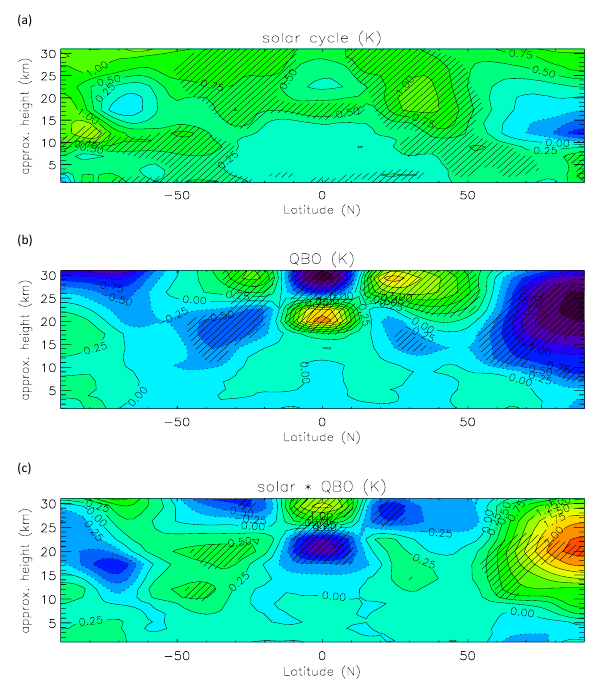
Figure 6 Results from multiple linear regression analysis of NCEP reanalysis zonal mean monthly mean temperatures (1958-2004). (a) and (b) show the signals associated with solar variability and the QBO, respectively, when these are included as independent indices in a multiple regression. (c) shows the results of a different analysis in which the compound index is used in place of the two individually. The contour interval is 0.25K; positive values have solid lines and green-red colouring, negative values dashed lines and blue-black; hatching indicates a signal ascertained to be statistically significant at the 5% level.